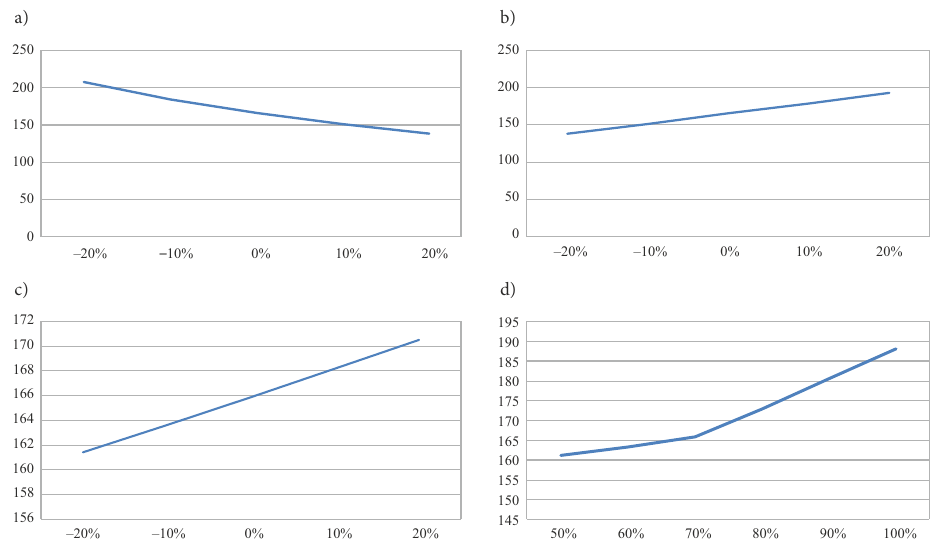
Figure 2. Sensitivity analysis: main results: a – Annual Net Electricity Production; b – Total investment; c – O&M costs; d – Equity